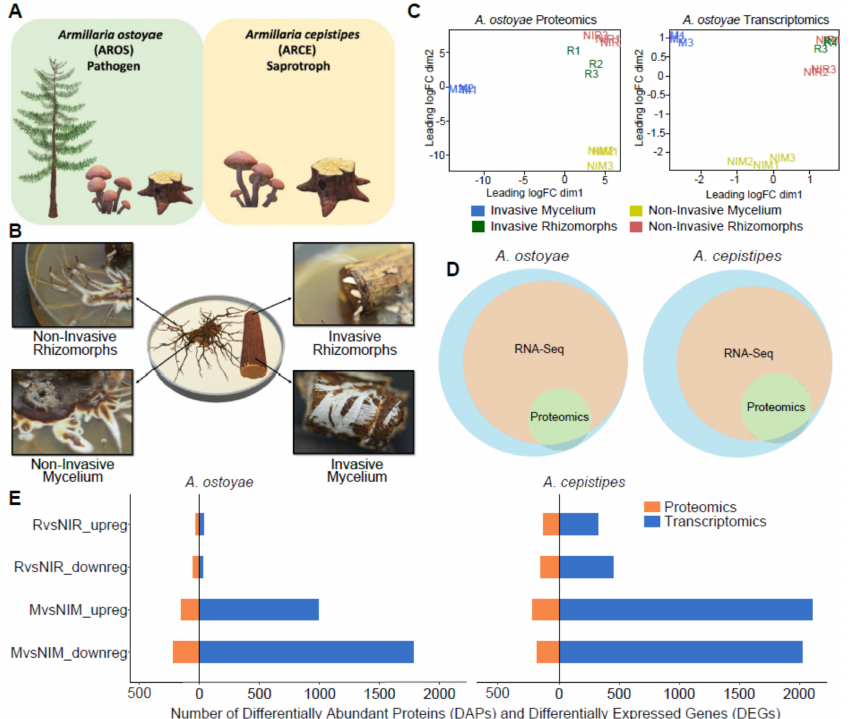
Figure 1. Overview of the experimental approach for root decay studies. ( A ) Representation of Armillaria ostoyae (pathogenic) and A. cepistipes (saprotroph) used in this study, ( B ) The four tissue types sampled for transcriptomics and proteomics analysis, viz., invasive mycelium (growing beneath the outer layer of root), invasive rhizomorphs (emerging out of the roots), non-invasive mycelium and non-invasive rhizomorphs (growing in absence of root). A. ostoyae is shown as an example, ( C ) Multidimensional scaling of three biological replicates from each of the tissue types in A. ostoyae for proteomics (left) and transcriptomics (right), ( D ) Proportion of transcripts and proteins detected in the two -omics analysis. The blue circle represents the whole proteome, orange depicts the transcripts detected in the RNASeq, and green represents the proteins detected in the proteomics analyses. ( E ) The number of differentially expressed genes (blue) and differentially abundant proteins (orange) detected in the two